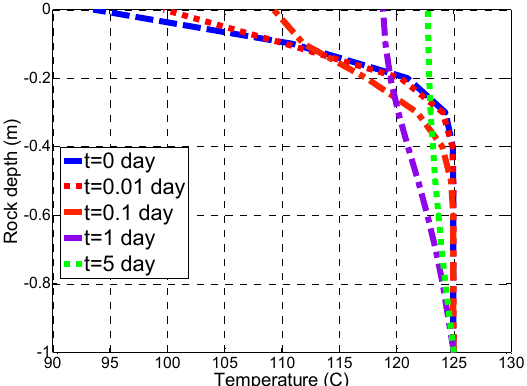
Figure 15. Fracture wall temperature heat recovery profile for x = 0.5 m, and five different time steps given in the legend. The initial rock temperature profile is the same as Figure 10b, which is the rock interior temperature profile after t = 0.1 day, velocity = 0.0368 m/s.